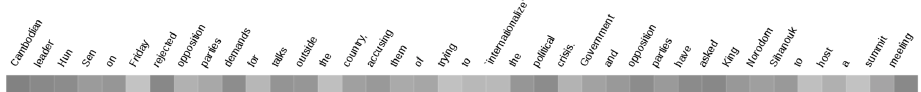
Figure 5. The weight heat map. The word in the picture is the source text. The darker color has